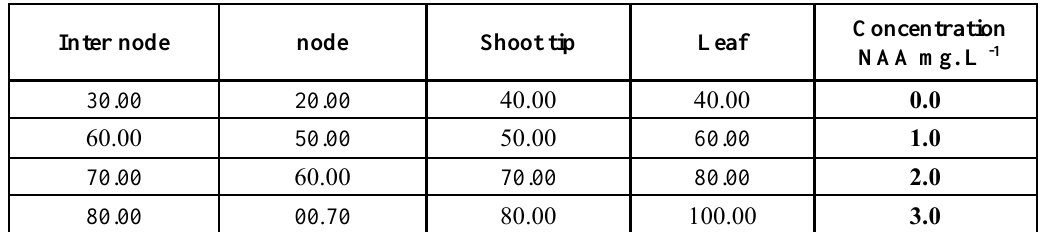
Table 4. Effect of different NAA auxin concentrations on the percentage of callus induction of stevia in vitro